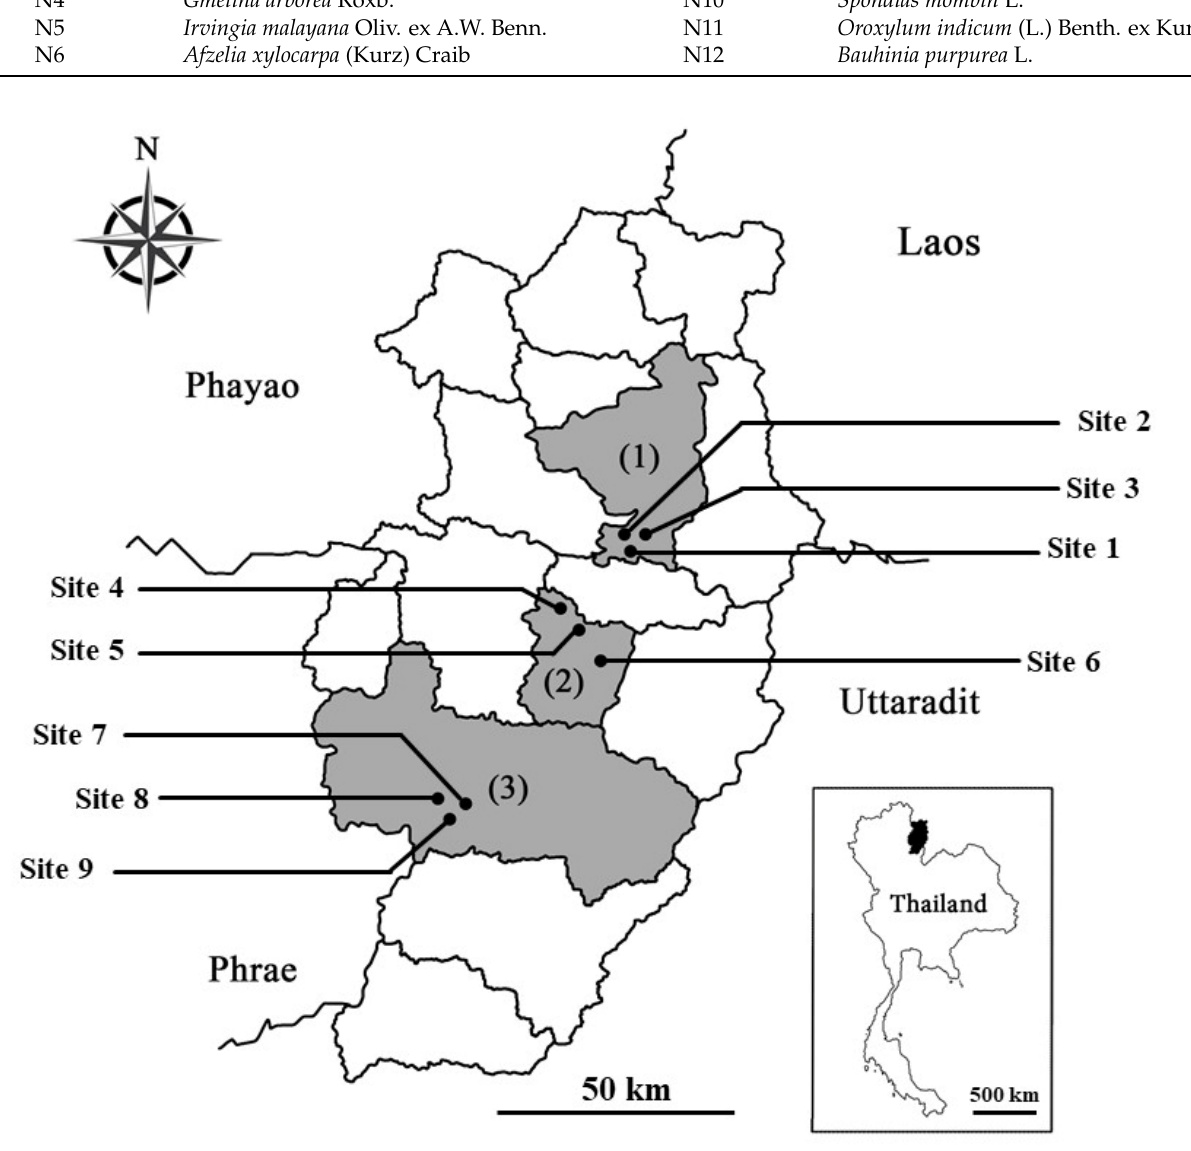
Figure 1. Locations of the nine sampling sites (black circle) in (1) Pua, (2) Phu Phiang, and (3) Wiang Sa districts in Nan, Northern Thailand.